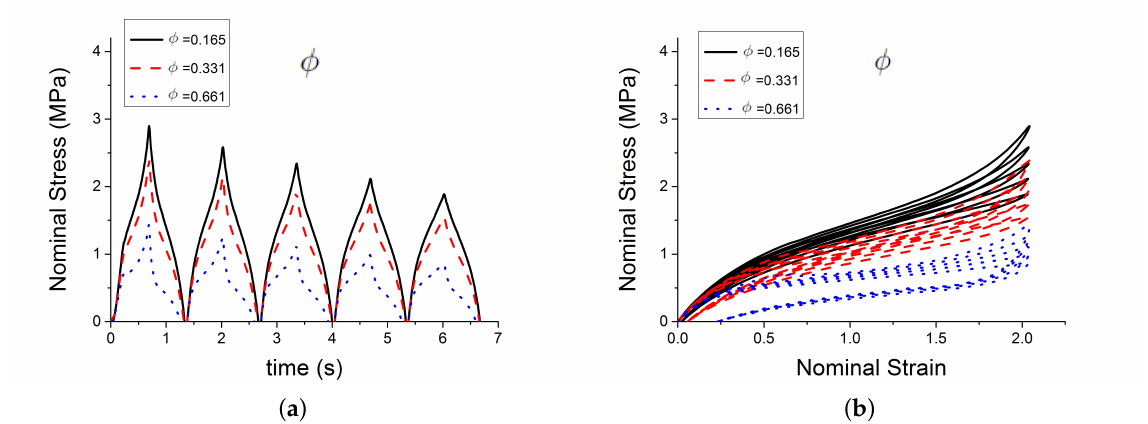
Figure 7. Influence of parameters. ( a , b ) show the effect of the parameter φ .